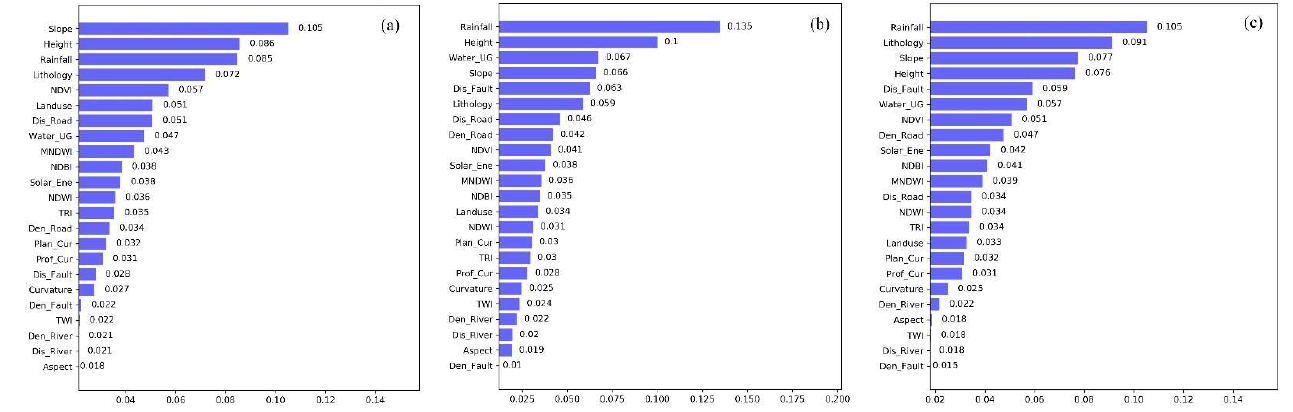
Figure 7. Feature importance ranking results using filter-MDI. The values are the average impurity of each feature: ( a ) Landslide; ( b ) Collapse; ( c ) Unstable slope. Table 6. Changes in model score and AUC after using filter-MDI feature selection method.